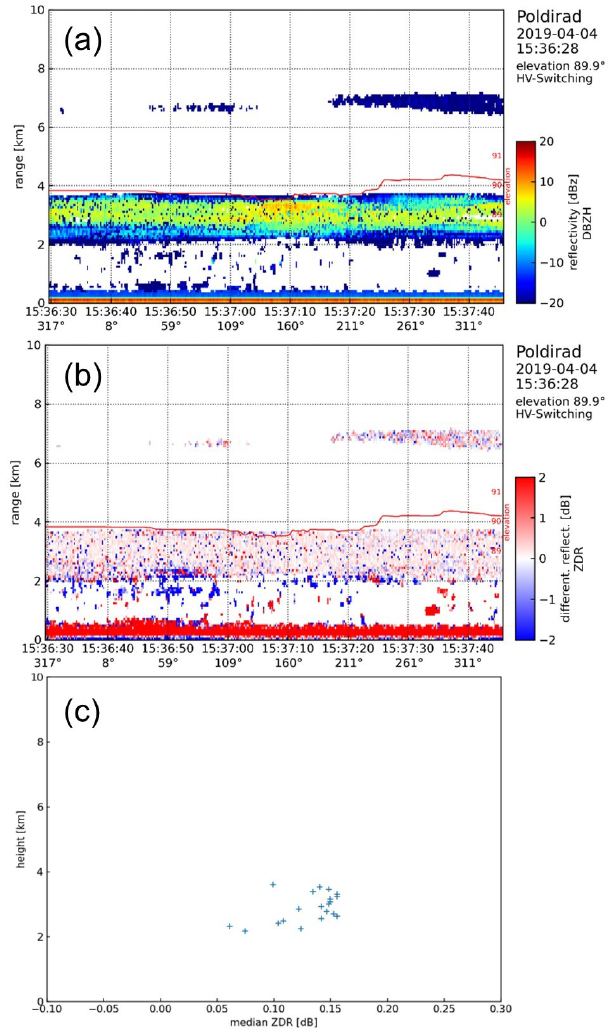
Figure A1. POLDIRAD (a) Z e and (b) ZDR measurements of a liquid cloud layer for different times and azimuth angles with a ver- tically pointing antenna on 4 April 2019. Panel (c) shows the offset of the averaged ZDR for the range wherein the liquid layer was de-